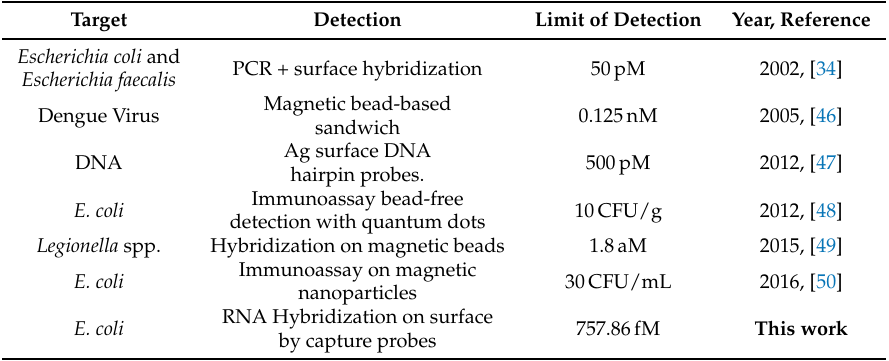
Figure 12. Calibration curve of detection, based on data from Table 2 (red circles). Measurement difference between LED ON and empty COC background (net fluorescence). Interpolation using MATLAB smoothing spline interpolation (blue line). Table 4. Performance comparison from selected references of fluorescence